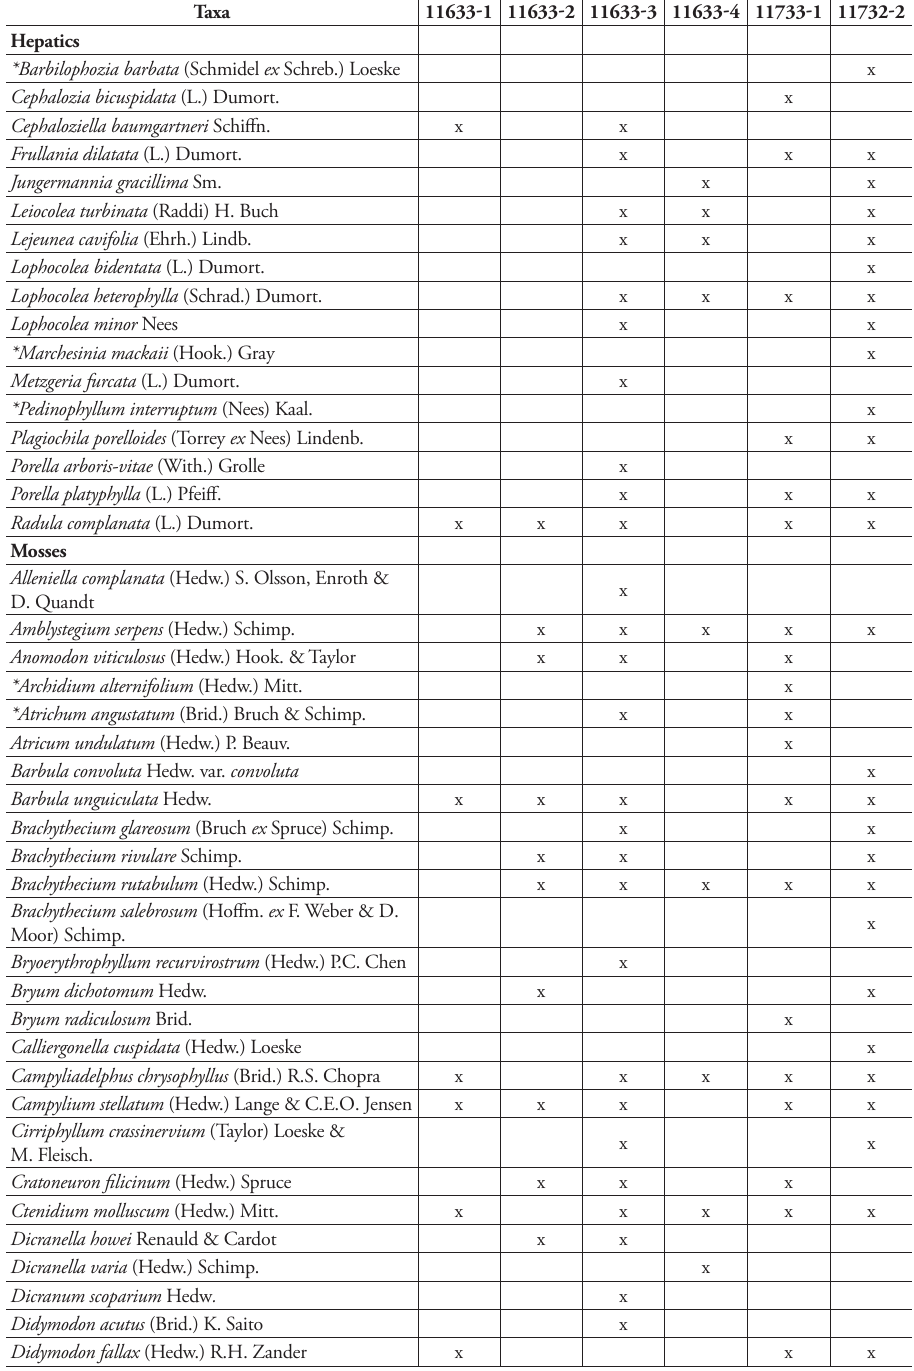
Table 1. List of the species identified in the different